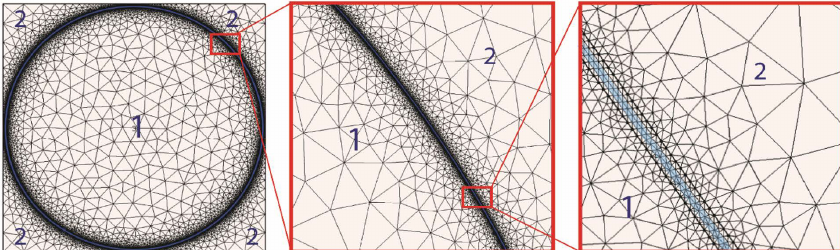
Figure 8. The triangular mesh used for the numerical model shown in Fig. 7. To distinguish between the phases: quartz is denoted with #1, GH is denoted with #2, and the interfacial water film is depicted in light blue.